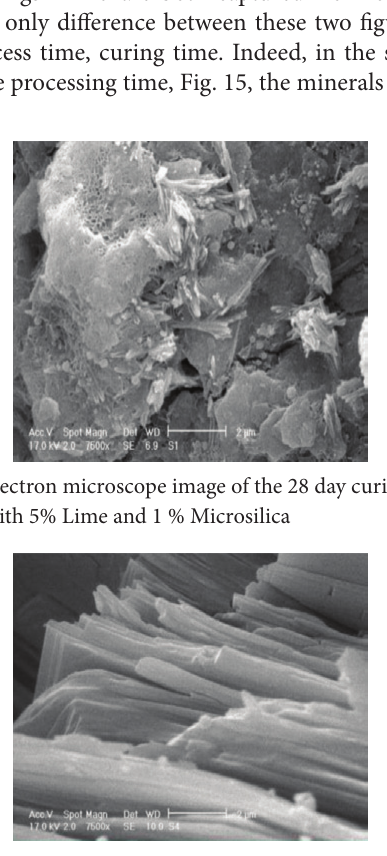
Fig. 16. Electron microscope image of the 7 day curing samples with 5% Lime and 10% Microsilica